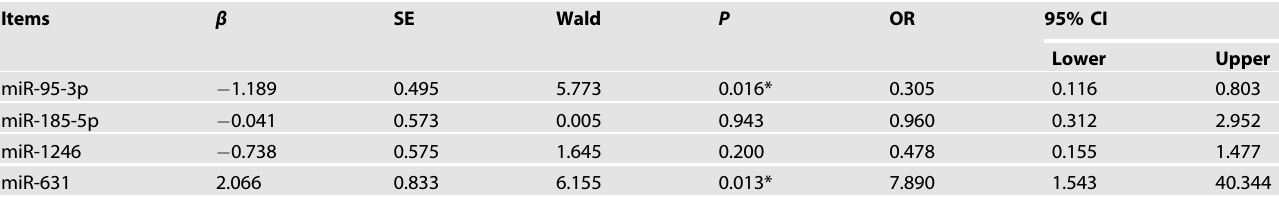
Table 4. Multivariate Cox regression analysis for dialysis-free survival of patients with diabetic